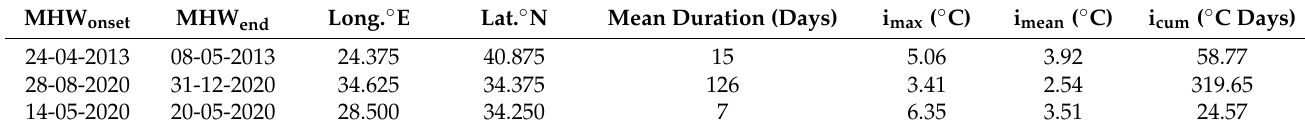
Table 2. The EMED extreme significant ( p < 0.05) MHW events characteristics (mean duration (Days), i max ( ◦ C), i mean ( ◦ C), and i cum ( ◦ C days)) over the study period (1982–2020) with the corresponding MHW onset , MHW end , Longitude and Latitude in degrees where the highest events are highlighted in yellow color.